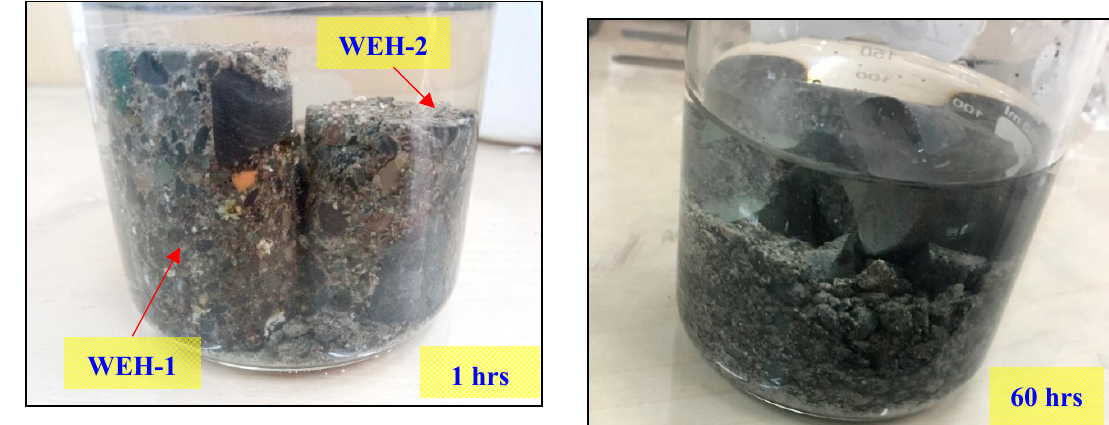
Figure 15. The surface change of the WEH-1 and WEH-2 samples with the soaking time.